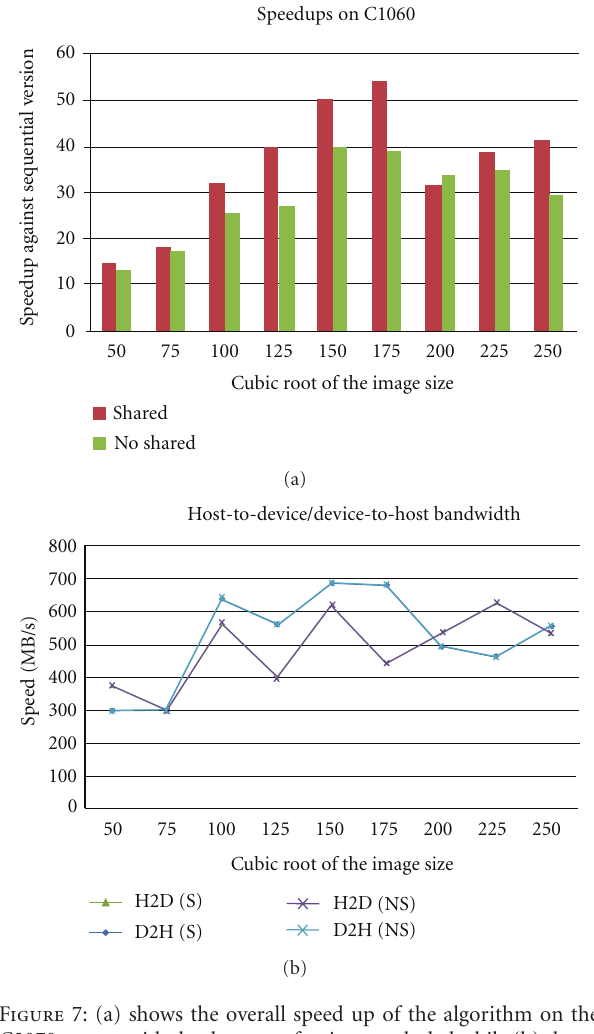
Figure 7: (a) shows the overall speed up of the algorithm on the C2070 system with the data transfer times excluded while (b) shows the variation of transfer speed with the image size.